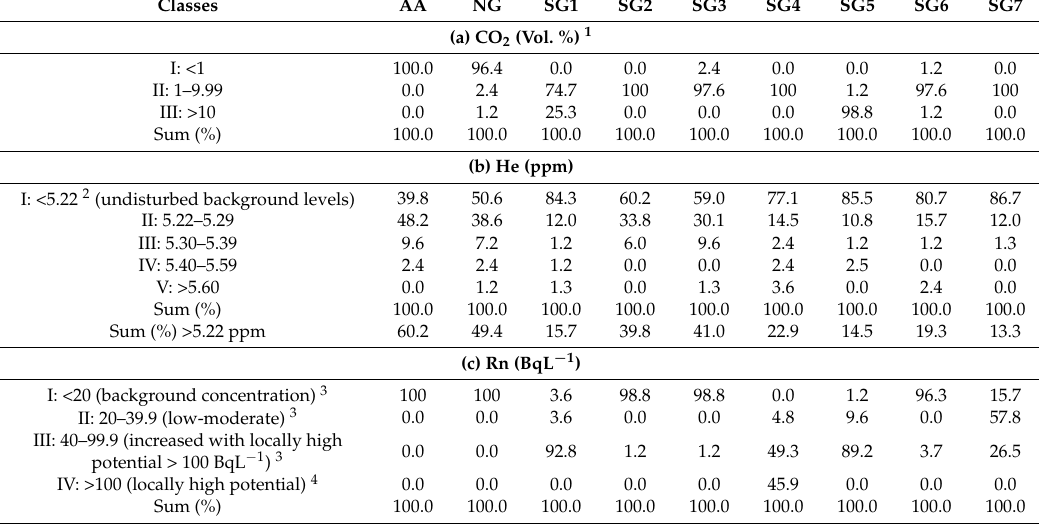
Table 2. Concentration classes of gases for AA, NG and SG for the 4-W sampling. CO 2 classes after [42]; atmospheric He after [18]; and Rn background concentrations after [43] and [44].